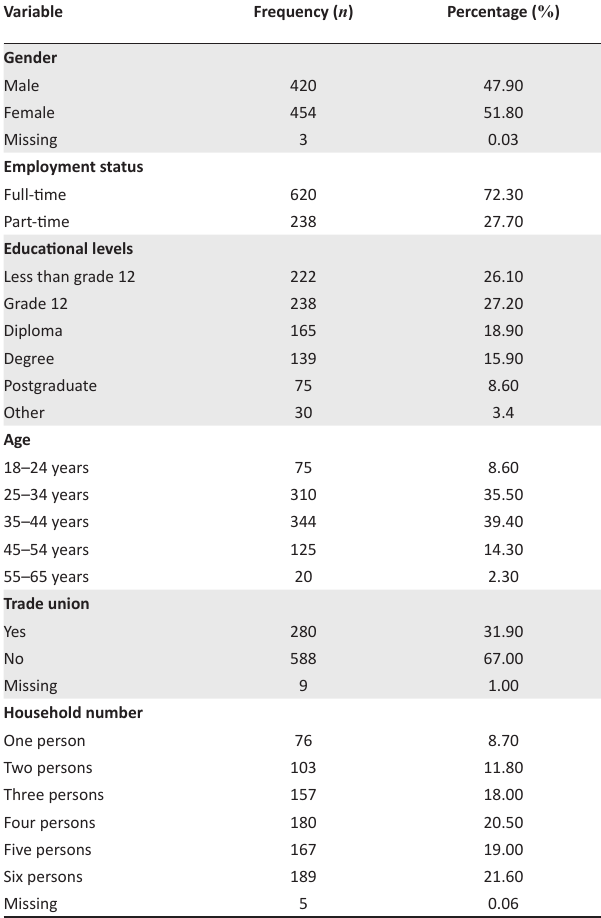
TABLE 1: Distribution of